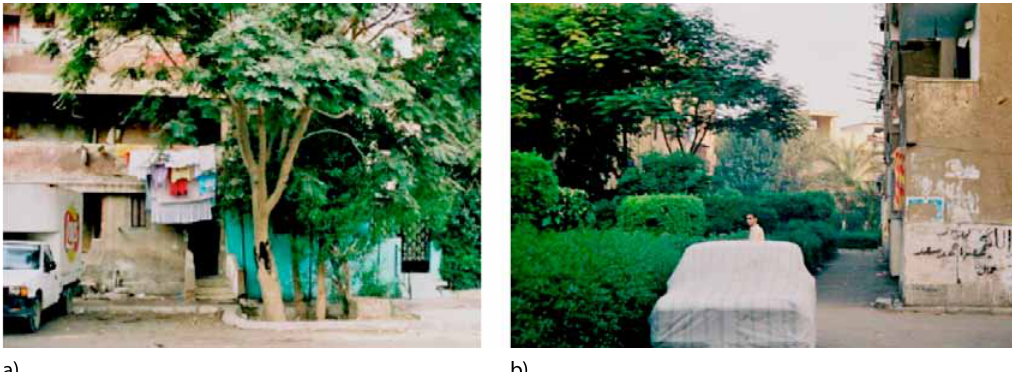
fig. 6a, b: Some examples of appropriating the fina’s for gardening as a significant prevalent activity by residents in Masakin Mohie transformed public housing case study